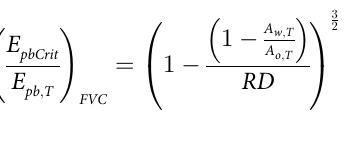
plotted for each subject vs. mean